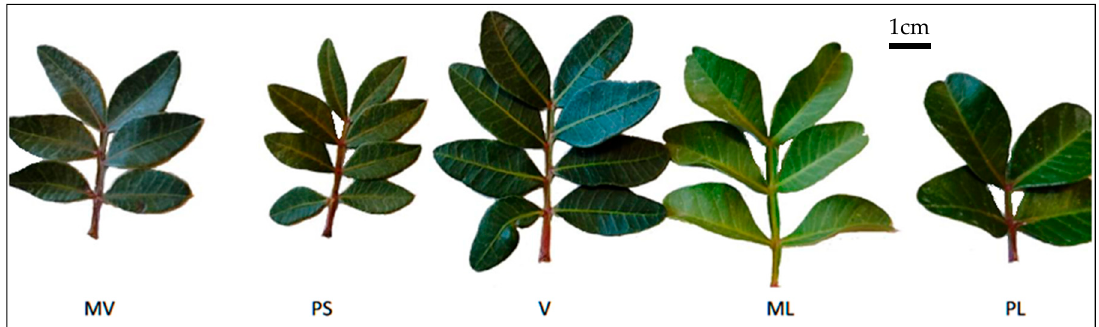
Figure 7. Composite leaves of the five cultivars ‘Mavroschinos’ (MV), ‘Psilophyllos’ (PS), ‘Votomos’ (V), ‘Maroulitis’ (ML) and ‘Platiphyllos’ (PL) of P. lentiscus var. Chia.